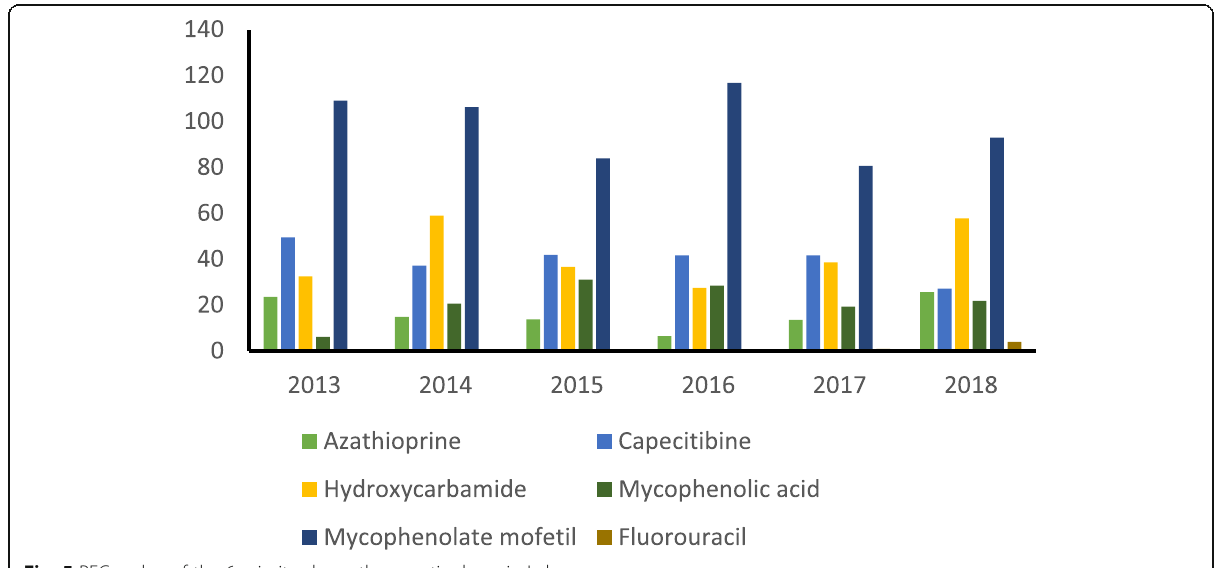
Fig. 5 PEC b value of the 6 priority chemotherapeutic drugs in